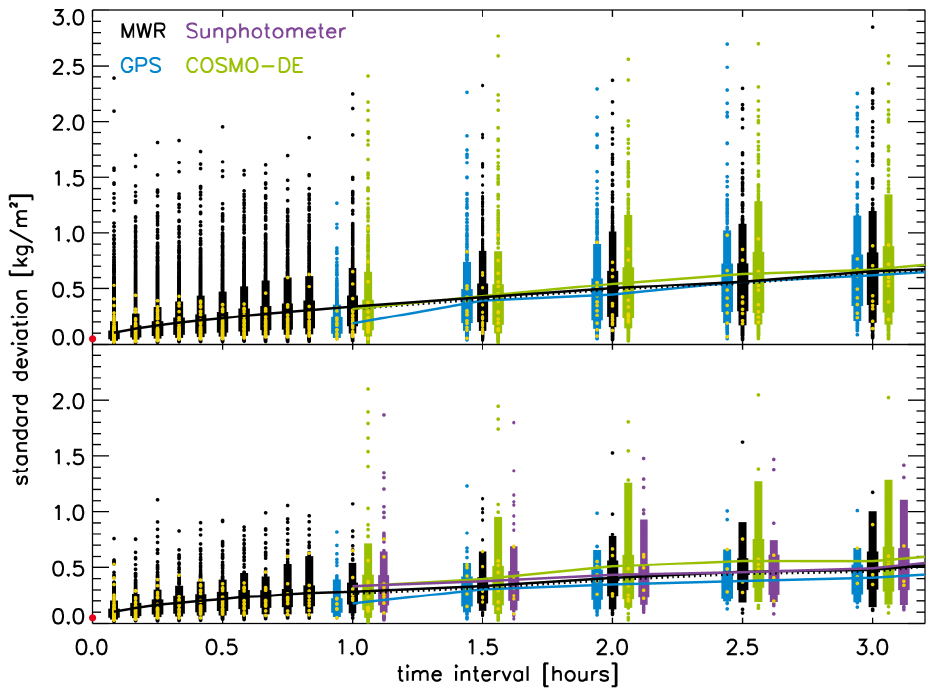
Figure 8. Lines: mean standard deviation of IWV during HOPE computed for varying intervals. Displayed are: MWR with 15min resolution (dotted black), MWR with 5s resolution (solid black), GPS (blue), and COSMO-DE (green). For the 5s MWR measurements, the GPS measurements, and the COSMO-DE simulation the vertical bars indicate the 10, 25, 75, and 90%-percentiles of the standard deviation. The single dots indicate the outliers. The data points from the case study (cf. Fig. 2) are given in yellow. The bottom panel additionally includes sun photometer data (purple) and is limited to coincident measurements during daytime clear-sky conditions. The red dot on the y axis represents the noise level of the